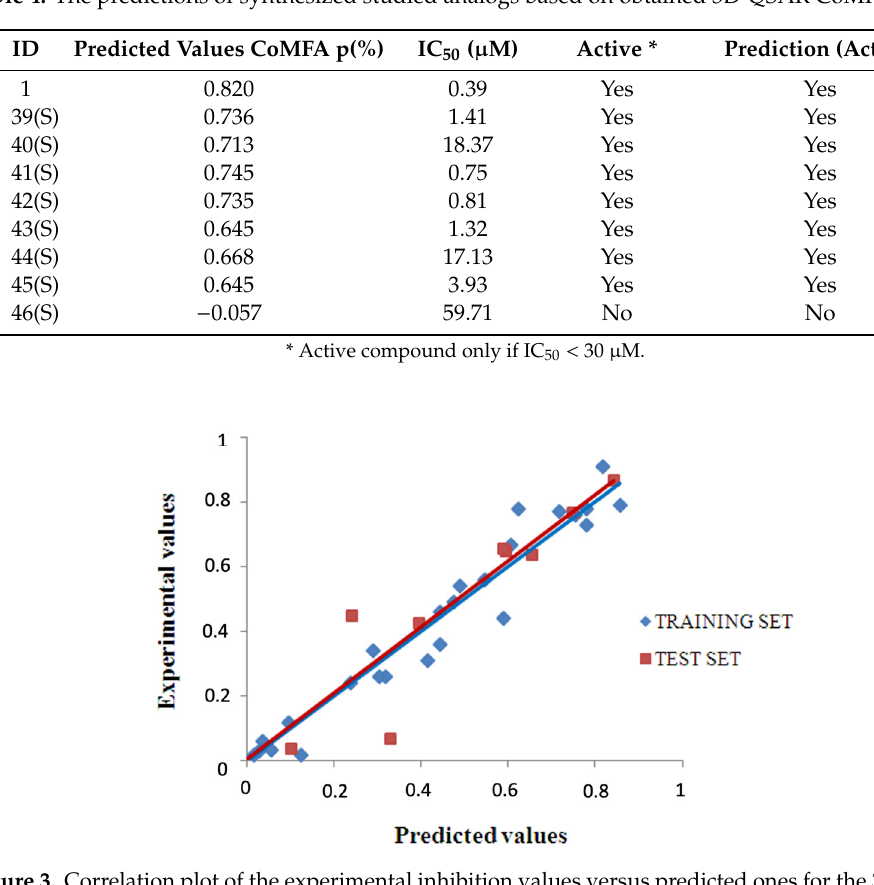
Table 4. The predictions of synthesized studied analogs based on obtained 3D-QSAR CoMFA model.